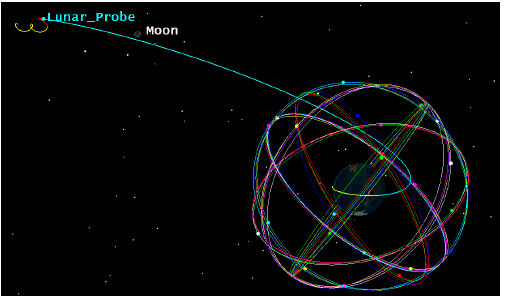
Figure 3. Assumed MTO for the receiver.